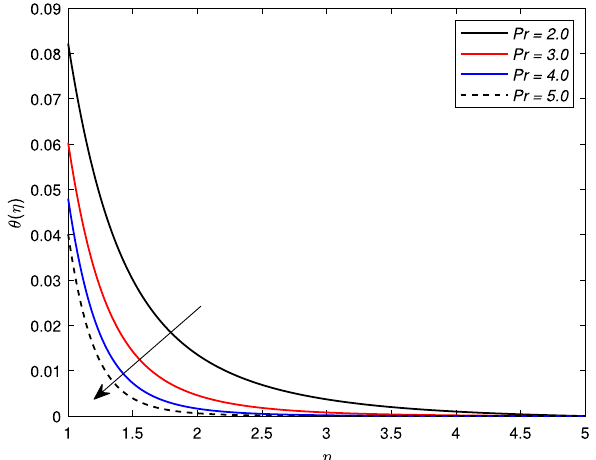
Figure 9. Impact of Prandtl number Pr on temperature profile θ(η) .